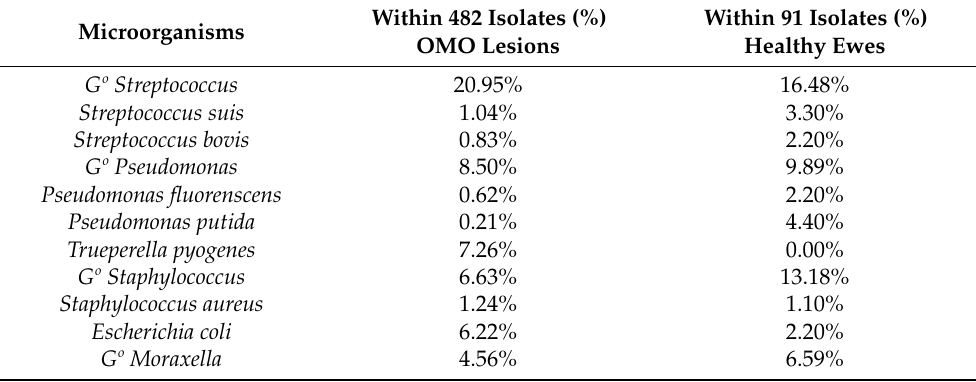
Table 3. Comparison between the main microorganisms isolated in sheep with mandibular os- teomyelitis and periodontally healthy